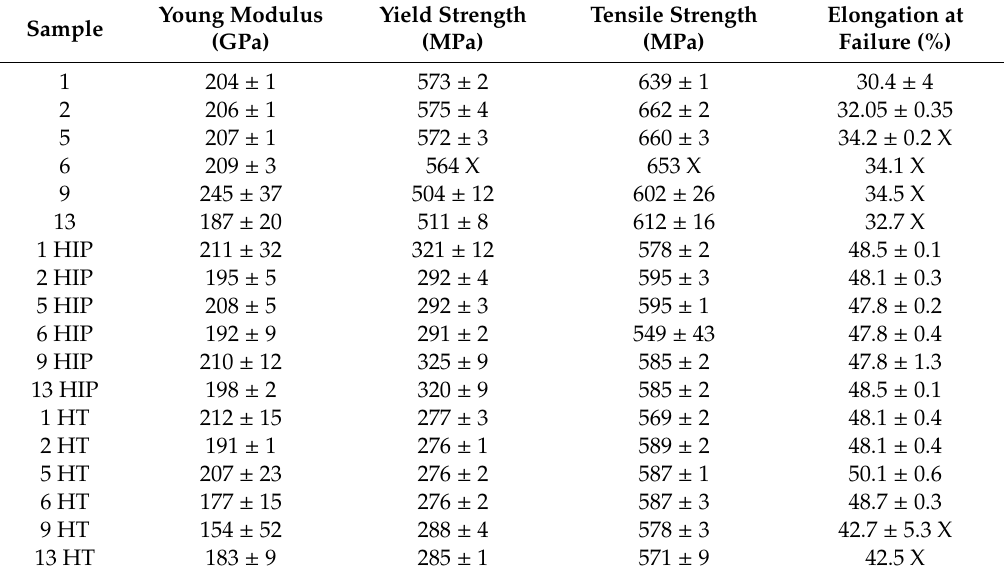
Figure 26. Stress–strain curves for sample 2 after SLM, SLM + HIP_2 and SLM + heat treated (HT). Table 7. Tensile properties for 316L steels after SLM, SLM + HIP_2 and SLM + HT (X indicates that some tensile specimens have failed outside the measured